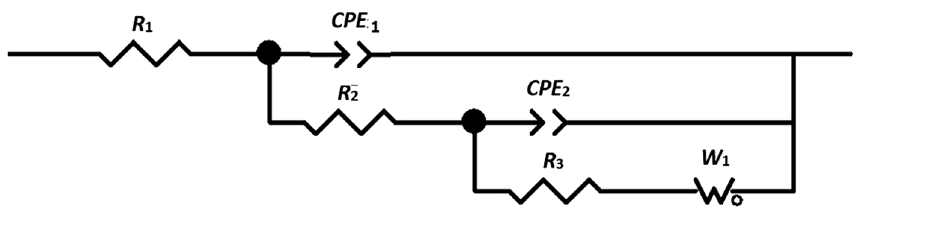
Figure 6. Equivalent circuit model